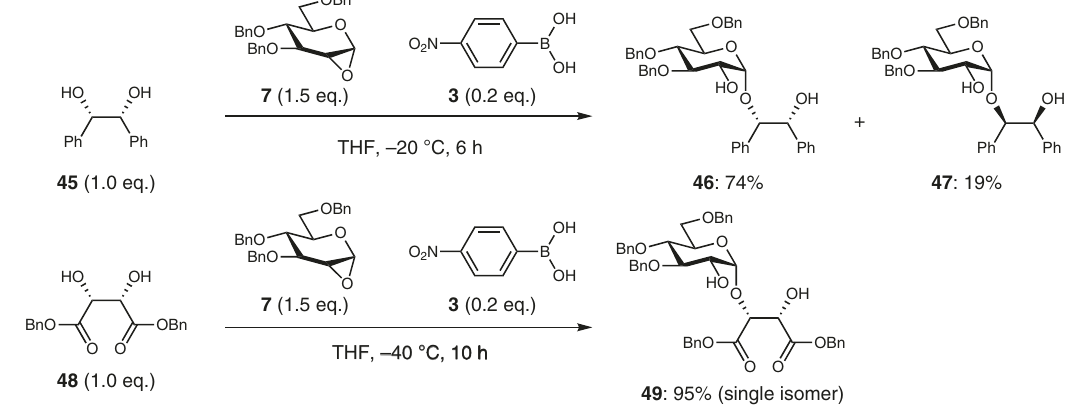
Fig. 6 Desymmetric glycosylation using acyclic meso -diols. In both cases, the formation of 1.2- trans glycoside was not